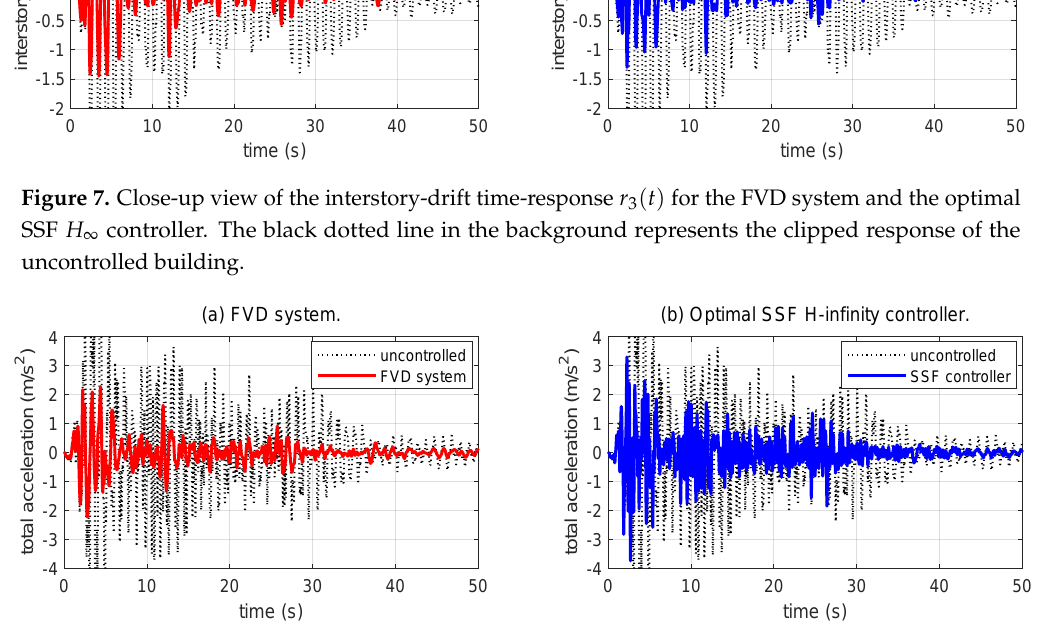
Figure 8. Close-up view of the total-acceleration time-response a 3 ( t ) for the FVD system and the optimal SSF H ∞ controller. The black dotted line in the background represents the clipped response of the uncontrolled